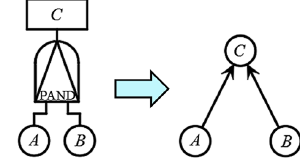
Figure 3. PAND gate and its corresponding CTBN